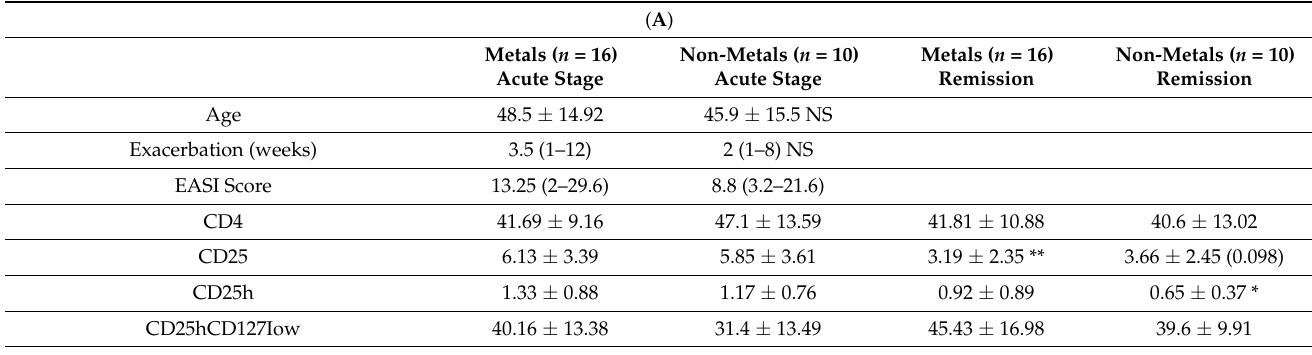
Table 5. ( A ) Comparison of selected variables in ACD patients depending on allergen. ( B ) Correla ‐ tions of the percentage of iOPN CD4 lymphocytes with selected variables in the ACD patients de ‐ pending on allergen. Data are presented as R values and followed with p values when p < 0.2.